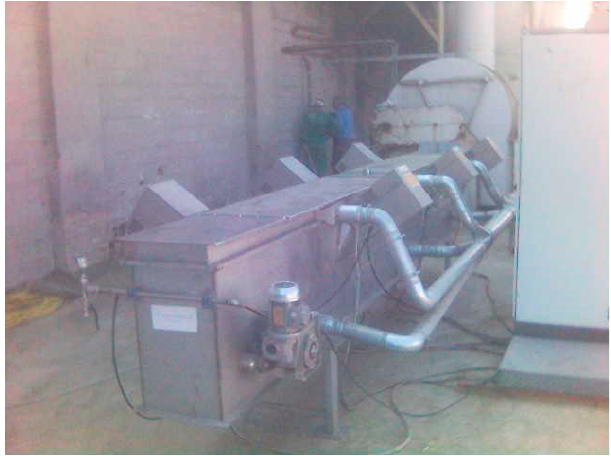
Figure 4. Pilot conveyor-belt dryer with tangential flow.